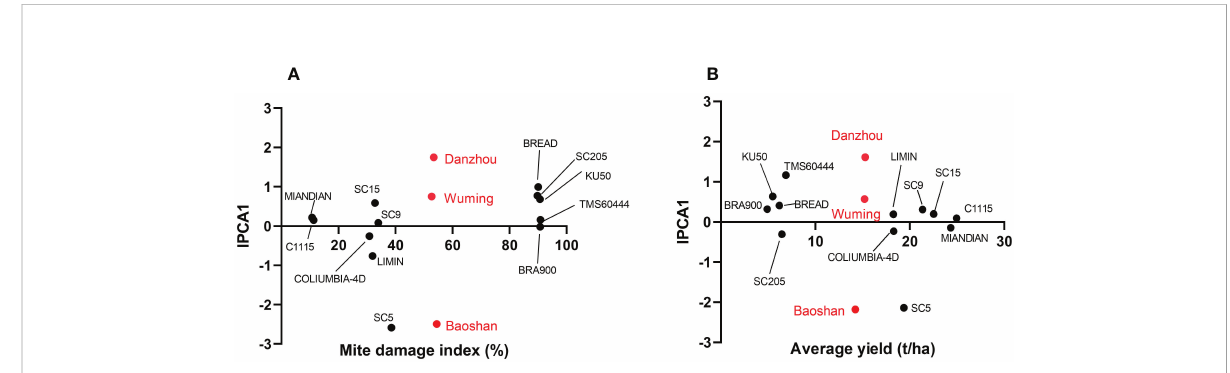
FIGURE 6 Stability analysis of the 12 cassava varieties and discrimination of regional sites by Additive main effects and multiplicative interaction biplot. (A) Mite damage index-based stability analysis of the 12 cassava varieties. (B) Yield-based stability analysis of the 12 tested cassava varieties. The 12 cassava varieties are marked with black circles, while the three regional sites are marked with red